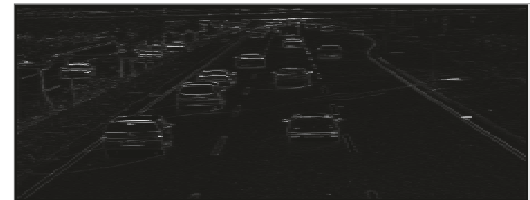
Figure 3: Median filter